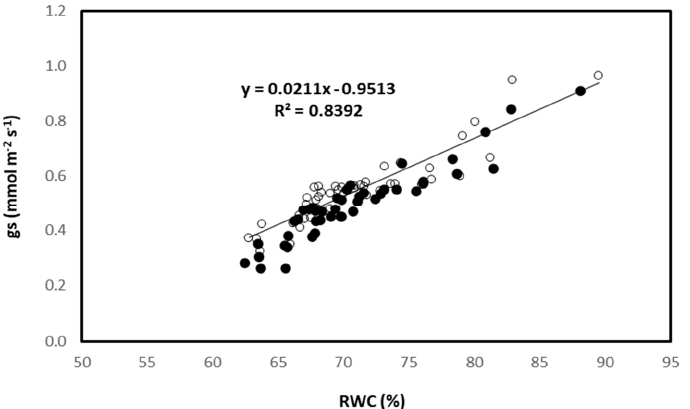
Figure 7. Leaf stomatal conductance (g s ) as a function of relative water content (RWC) in five milk thistle ecotypes (‘Ahvaz’, ‘Budakalazi’, ‘Khomin’, ‘Khoram Abad’, and ‘Sari’), cultivated under the application of chitosan or TiO 2 treatments (bulk, nanoparticles) at three concentrations (0, 50, and 100 mg L –1 ). Data of all ecotypes and treatments were pooled across years (Year 1, open symbols; Year 2, closed symbols). Table 7. Effects of chitosan and titanium dioxide (denoted as Ch and Ti, respectively) treatments [bulk, nanoparticle (NP)] applied at three concentrations (0, 50, and 100 mg L –1 ) on leaf gas exchange, photosynthetic state, and hydration status of five milk thistle ecotypes. Three plants per treatment were assessed. Different letters within a column indicate statistically significant differences ( p < 0.05). In parameters (P n , g s , T r , and F v /F m ) showing significant interaction effects among all three factors involved (ecotype × treatment × year); a comparison of year means is provided in Tables S2 and S3. P n , net photosynthetic rate; g s , stomatal conductance; T r , transpiration rate; F v /F m , ratio of variable to maximum fluorescence; RWC, relative water content.